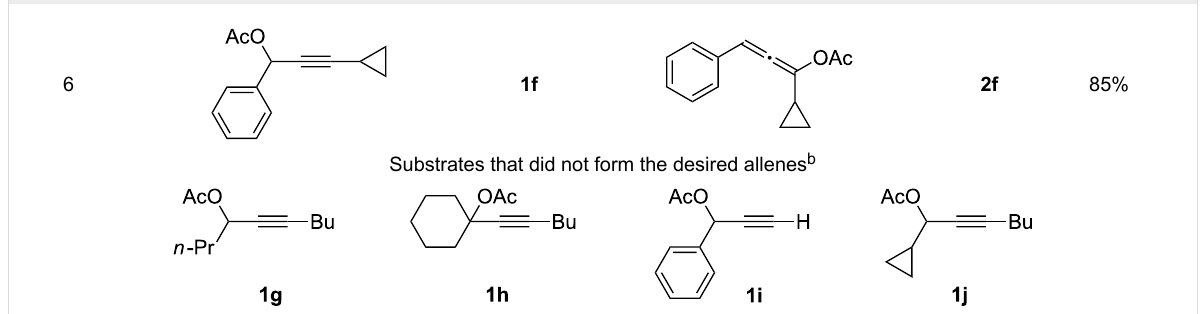
Table 1: The reaction substrate scope. a (continued)